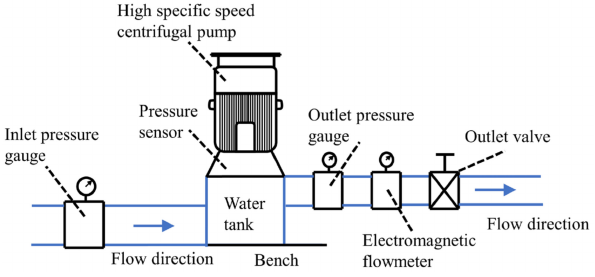
Figure 5. Schematic diagram of external characteristic test bench.